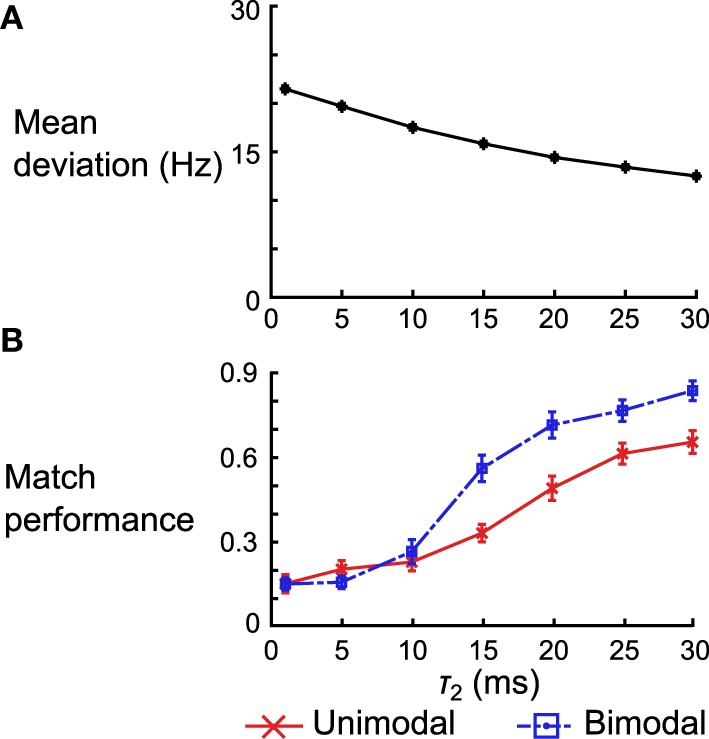
Effect of kernel shape on the performance of the delta rule network and the neural implementation of the Helmholtz Machine. (A) Mean deviation (across 50 instantiations of the network) between the output rate after training and the target rate across 50 instantiations of the delta rule network. The error bars are SEM, but are too small to be seen in this plot. (B) Mean matching performance for unimodal and bimodal data sets across 50 instantiations of the neural implementations of Helmholtz Machine. The error bars are SEM. Note that the performance is normalized by the number of data sets (e.g., a performance of 1.0 means all 5 mean distributions were matched in the unimodal data set category).